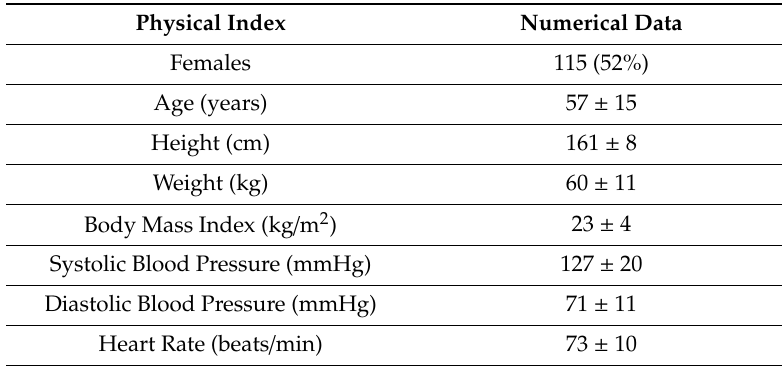
Table 1. Data summary.